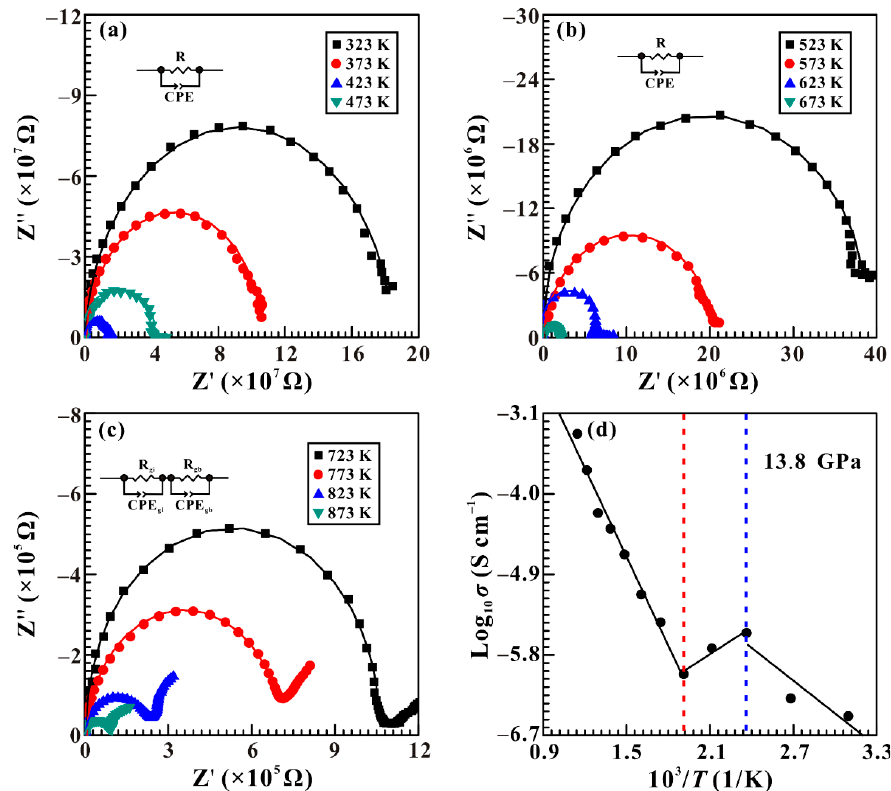
Figure 9. Complex impedance spectra of calcite in the temperature range of 323–873 K at 13.8 GPa. ( a ) 323–473 K; ( b ) 523–673 K; ( c ) 723–873 K. ( d ) The logarithmic electrical conductivity of calcite against reciprocal temperature. Z’ is the real part of the complex impedance spectra and Z” is the imaginary part. The colored curves are the results of the fitting to the impedance spectra. The black solid lines are obtained from the Arrhenius fitting results of the data. Table 4. The fitted parameters for the Arrhenius relation of the electrical conductivity of calcite. P is the pressure, T is the absolute temperature, σ 0 is the pre-exponential factor, Δ H is the activation enthalpy, and R 2 is the linear correction.